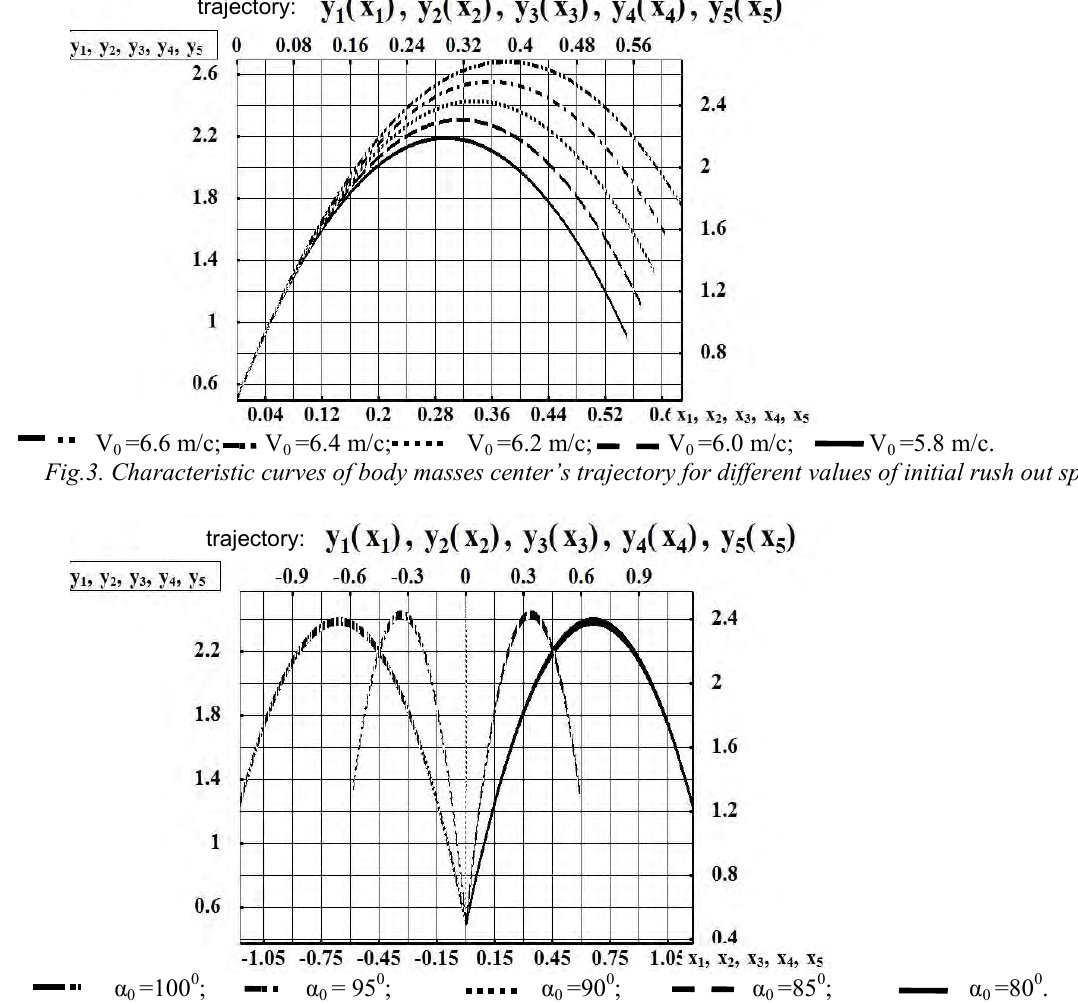
Fig.4. Characteristic curves of body masses center’s trajectory for different values of initial rush out angles.